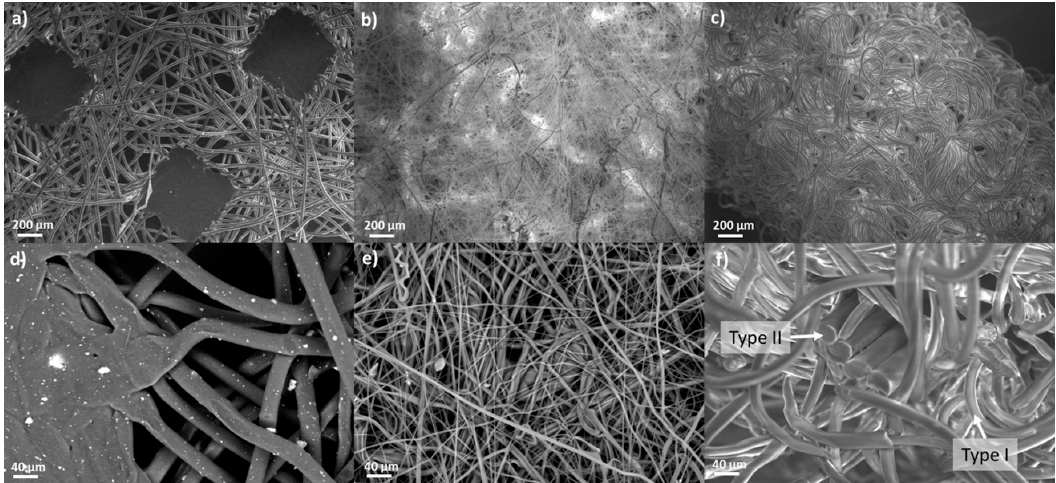
Figure 2. SEM magnification of: ( a , d ) inner part of the face mask (FM); ( b , e ) central filtering layer of FM; ( c ) ear loop (EL) and ( f ) EL section.